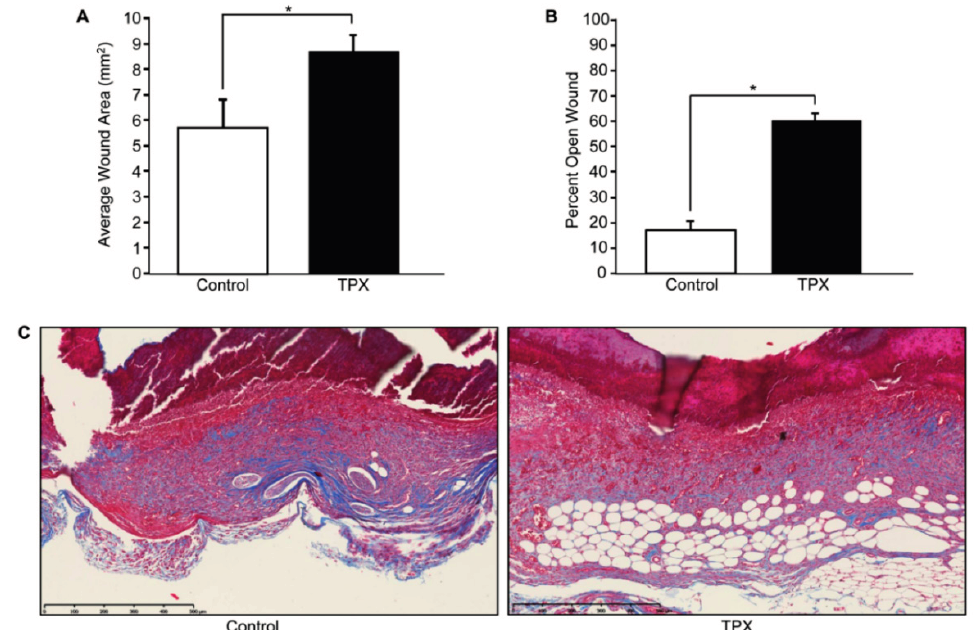
Figure 4. Tiplaxtinin reduces cutaneous wound closure and collagen deposition.